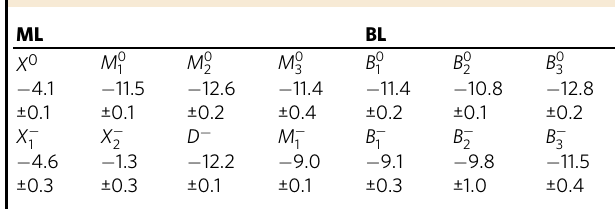
Table 1 Experimental exciton g -factors in charge-controlled monolayer and bilayer WSe 2